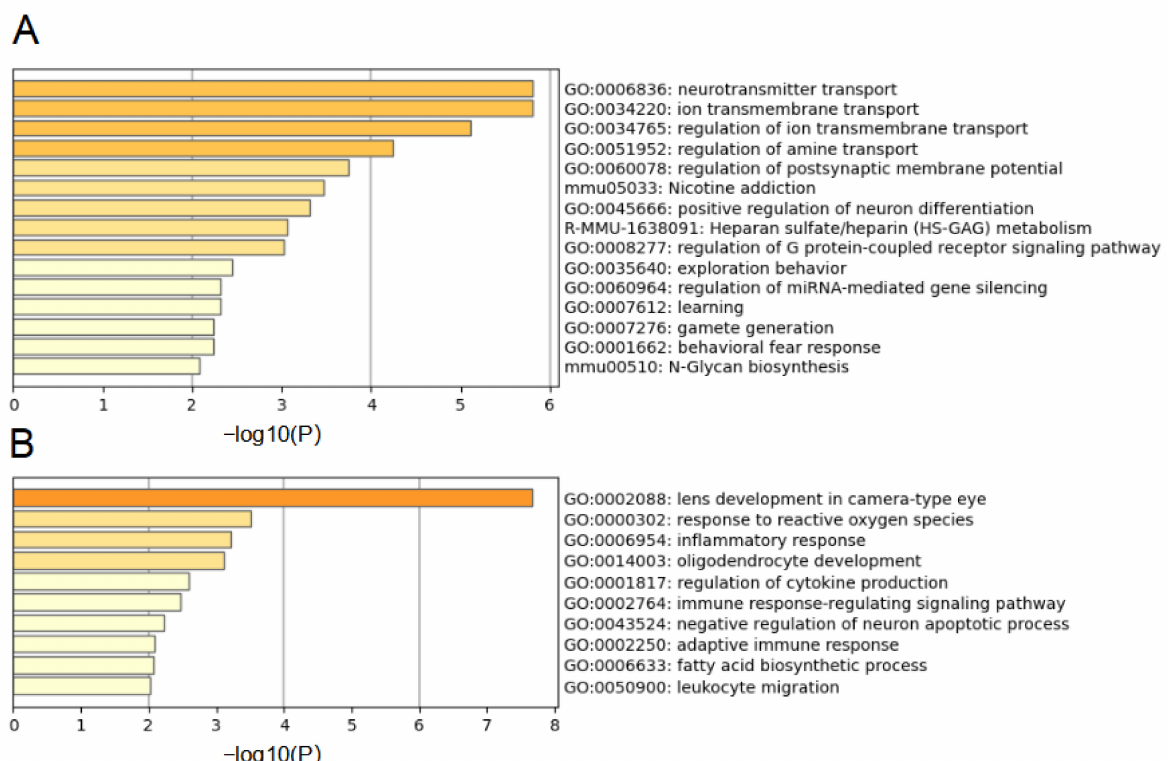
Figure 3. GO and KEGG pathway analysis of DEGs. ( A ). GO and KEGG pathway analysis for up-regulating DEGs. ( B ). GO and KEGG pathway analysis for down-regulating DEGs.